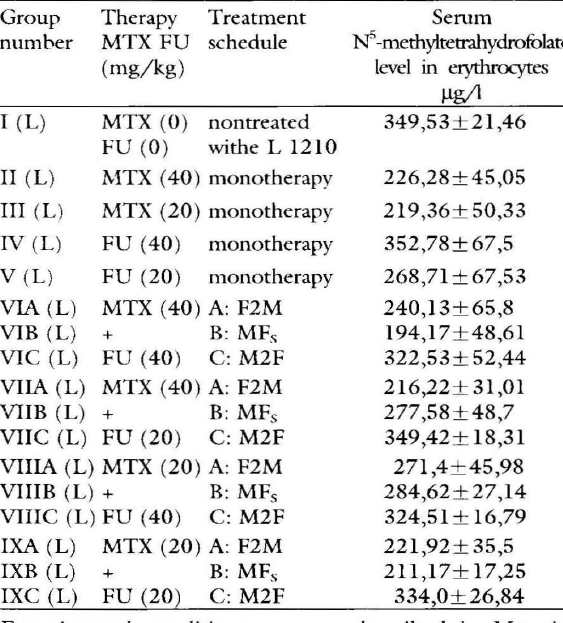
Table 13. N 5 -methyltetrahydrofolate levels in erythro cytes of BDF, mice with LI210 leukemia after ad ministration of MT X, FU and combined therapy ac cording to different